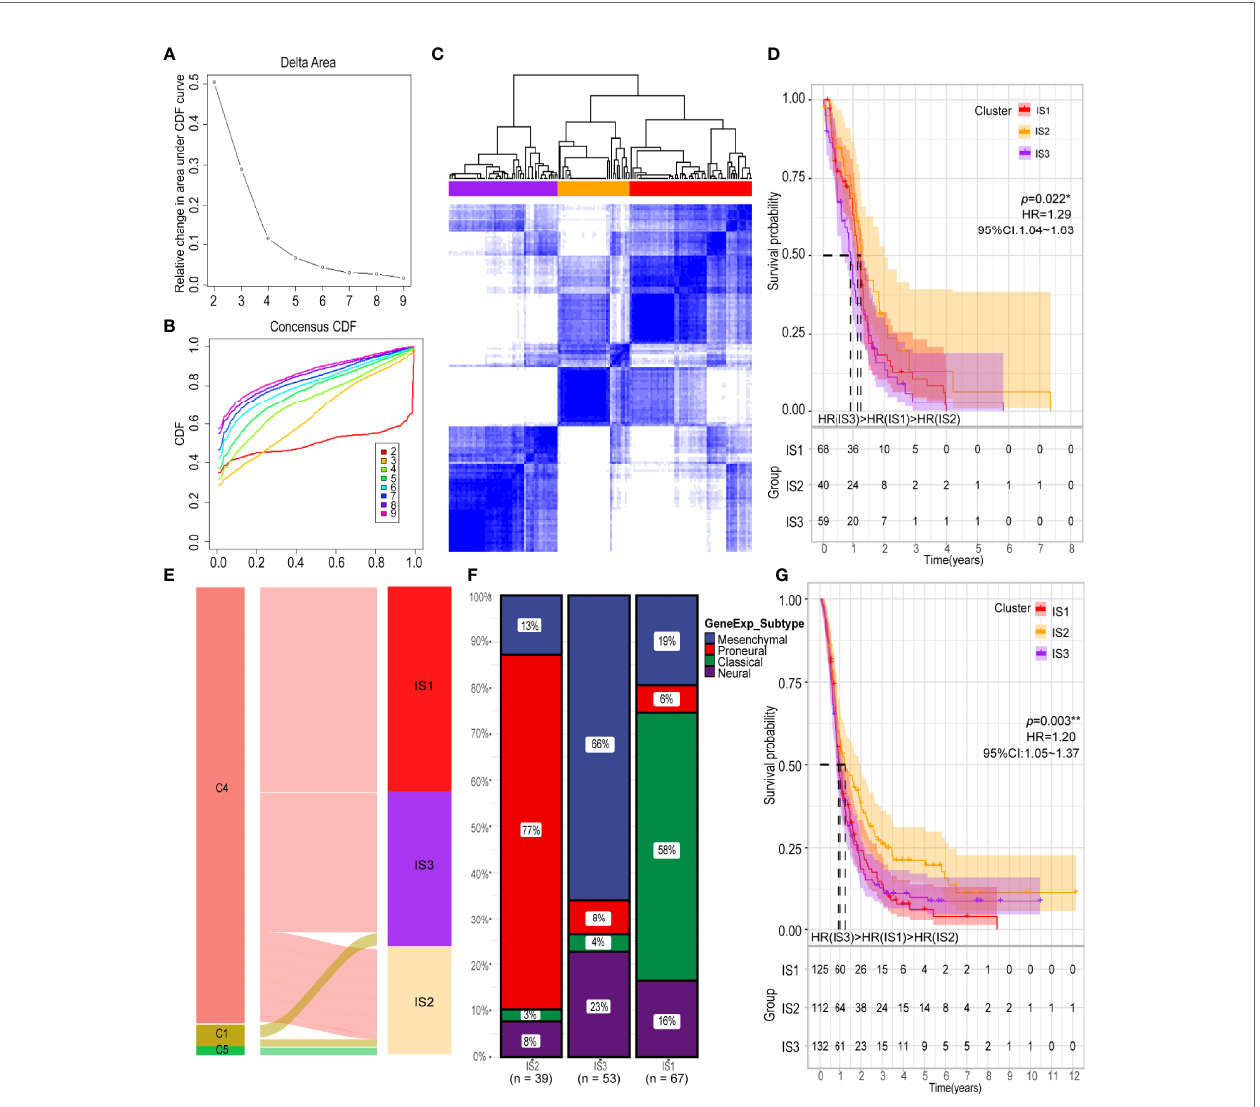
FIGURE 4 | Identi fi cation of potential immune subtypes of GBM. (A) Cumulative distribution function curve and (B) delta area of immune-related genes in TCGA cohort. (C) Sample clustering heat map. (D) Kaplan-Meier curves showing OS of GBM immune subtypes in TCGA cohort. (E) Overlap of GBM immune subtypes with three pan-cancer immune subtypes (NC1 = 2, NC4 = 158, NC5 = 1). (F) Distribution of four gene expression subtypes across IS1-IS3 in TCGA cohort. (G) Kaplan-Meier curves showing OS of GBM immune subtypes in CGGA cohort. * p < 0.05, ** p <